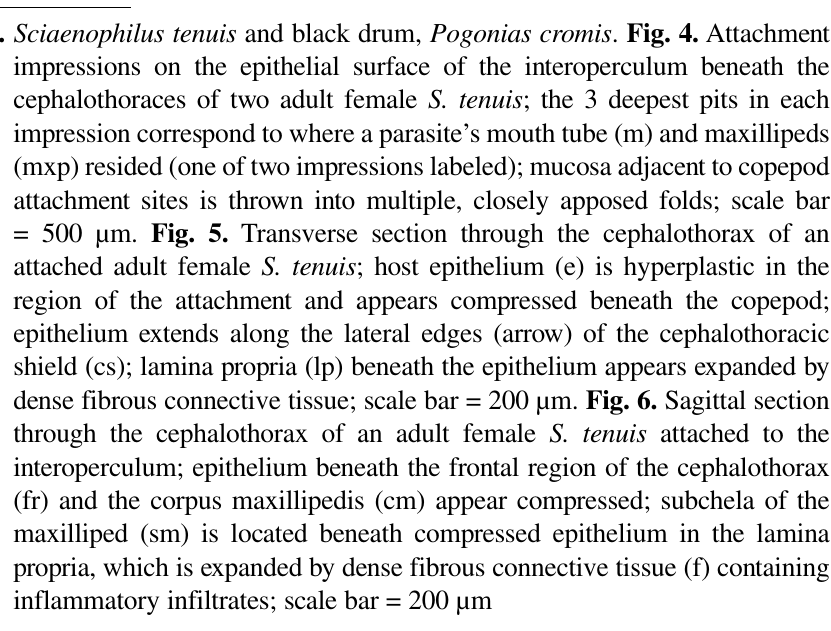
Figs. 4–6. Sciaenophilus tenuis and black drum, Pogonias cromis . Fig. 4. Attachment impressions on the epithelial surface of the interoperculum beneath the cephalothoraces of two adult female S. tenuis ; the 3 deepest pits in each impression correspond to where a parasite’s mouth tube (m) and maxillipeds (mxp) resided (one of two impressions labeled); mucosa adjacent to copepod attachment sites is thrown into multiple, closely apposed folds; scale bar = 500 µm. Fig. 5. Transverse section through the cephalothorax of an attached adult female S. tenuis ; host epithelium (e) is hyperplastic in the region of the attachment and appears compressed beneath the copepod; epithelium extends along the lateral edges (arrow) of the cephalothoracic shield (cs); lamina propria (lp) beneath the epithelium appears expanded by dense fibrous connective tissue; scale bar = 200 µm. Fig. 6. Sagittal section through the cephalothorax of an adult female S. tenuis attached to the interoperculum; epithelium beneath the frontal region of the cephalothorax (fr) and the corpus maxillipedis (cm) appear compressed; subchela of the maxilliped (sm) is located beneath compressed epithelium in the lamina propria, which is expanded by dense fibrous connective tissue (f) containing inflammatory infiltrates; scale bar = 200